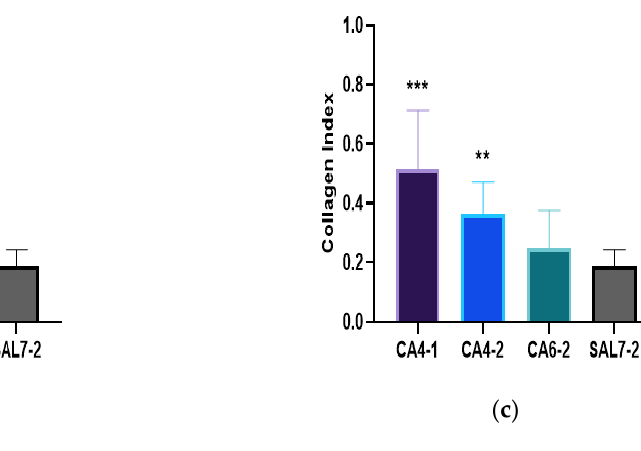
Figure 5. Evaluation of collagen deposition between phosphoric acid (PA) and citric acid (CA) treatment groups on day 7 post-wounding utilizing Masson Trichrome (MT) staining technique. ( a ) Histology analysis of skin sample obtained from all treatment groups. Original magnification 4×. Black scale bar represents 500 µm. ( b ) Collagen content evaluation between PA4-1, PA4-2, PA6-2 in comparison to SAL7-2 control group. ( c ) Differences in collagen index between CA4-1, CA4-2, CA6-2 and SAL7-2 control group. Each bar represents mean ± standard deviation. * p <0.05, ** p <0.01 and *** p < 0.001 indicates the results obtained were statistically significant from control group (SAL7-2).